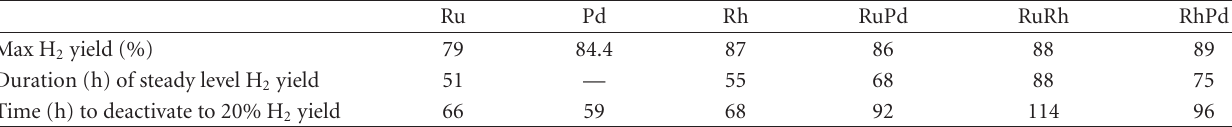
Table 1: Comparison of performance of the mono- and bimetal-supported catalysts.